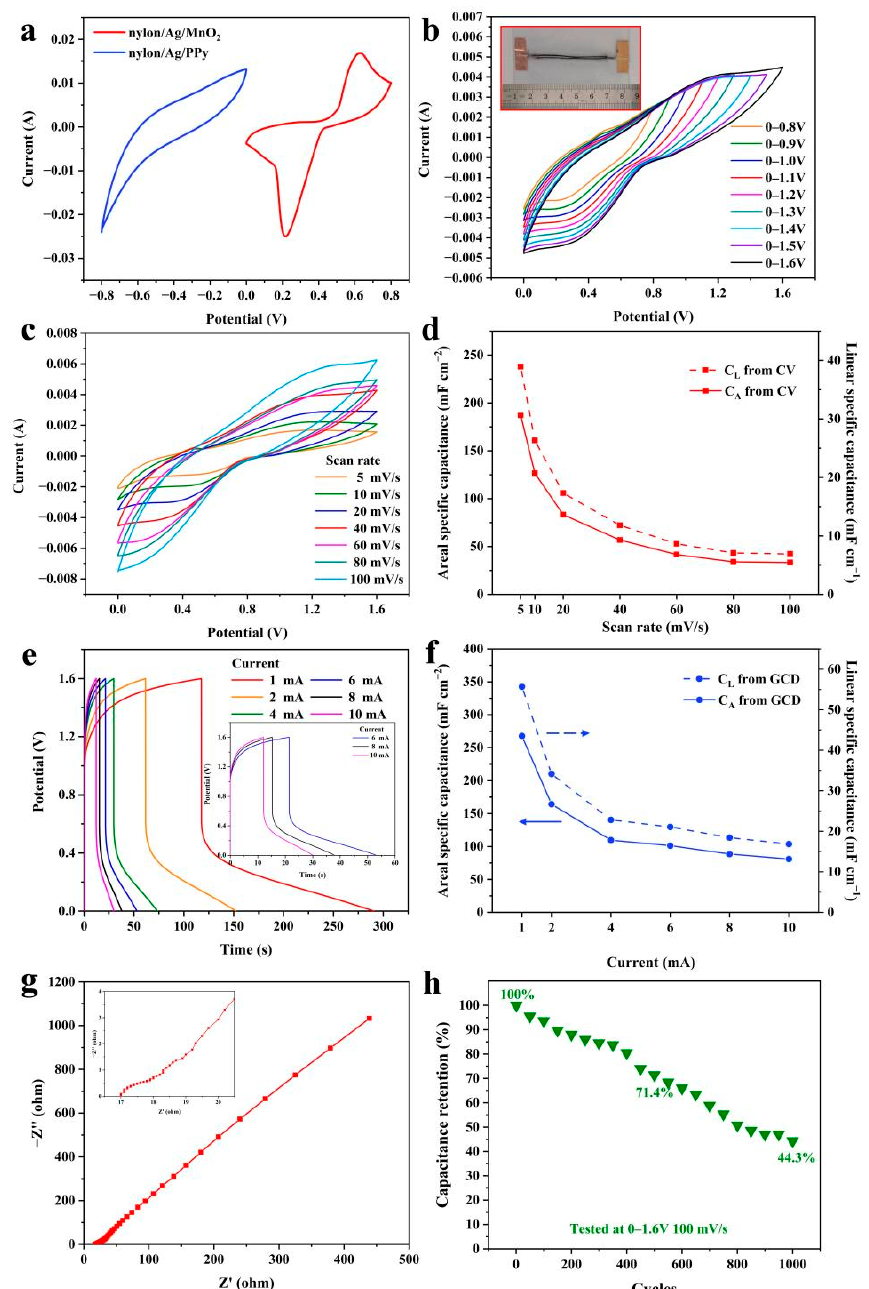
Figure 8. ( a ) Comparison of CV curves of the two electrodes at the scan rate of 40 mV s − 1 ; ( b ) CV curves of the device at 40 mV s − 1 in various potential windows (the inset shows the optical picture of the fabricated device); ( c ) CV curves of the device at di ff erent scan rates; ( d ) the C L and C A of the device calculated from CV curves; ( e ) GCD curves of the device at di ff erent charge/discharge currents (the inset shows the GCD curves from 6 mA to 10 mA); ( f ) the C L and C A of the device calculated from GCD curves; ( g ) EIS (the inset shows the enlarged view of the high-frequency region); ( h ) cycling stability test of the device at a scan rate of 100 mV s − 1 .